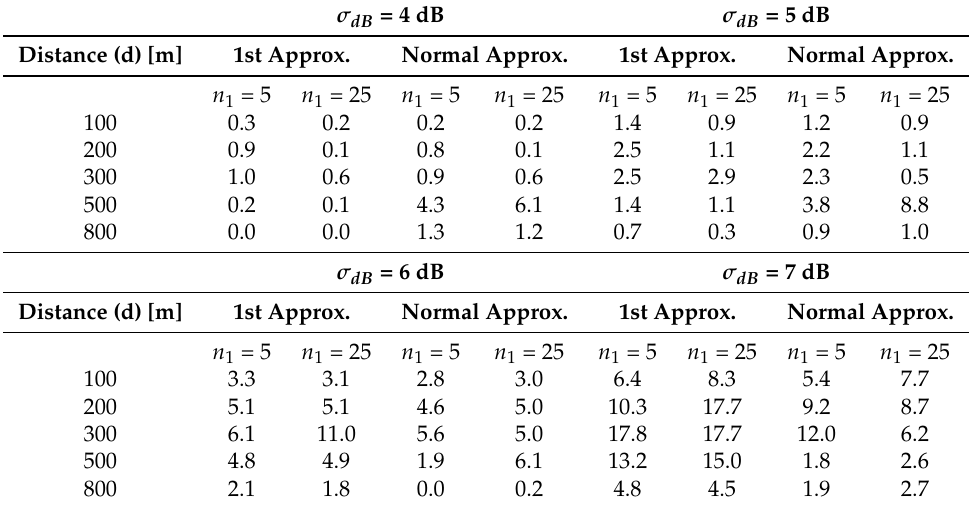
Table 1. Normalized differences (in percentage) of the 5th percentile with the distance d , n I = 5,25 and for variable σ dB